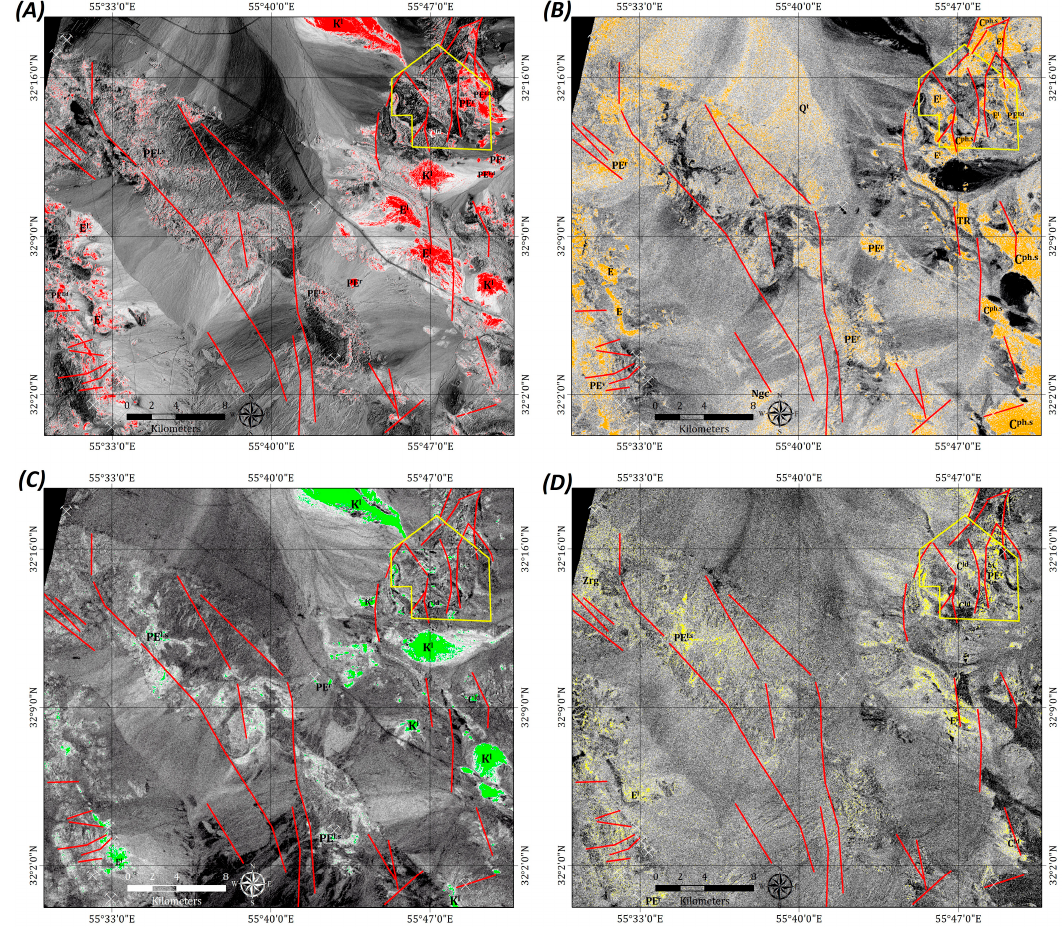
Figure 7. Band ratio image-maps showing spatial distribution of iron oxide / hydroxides Al / Fe-OH and Mg-Fe-OH / CO3 minerals and dolomite. ( A ) The 4 / 2 band ratio image-map of ASTER showing iron oxide / hydroxides minerals as red pixels; ( B ) the RBD1 image-map of ASTER showing Al / Fe-OH minerals as mustard pixels; ( C ) the RBD2 image-map of ASTER showing Mg-Fe-OH / CO3 minerals as green pixels; ( D ) the RBD3 image-map of ASTER showing dolomite as yellow pixels. Yellow polygon delineates WV-3 imagery.